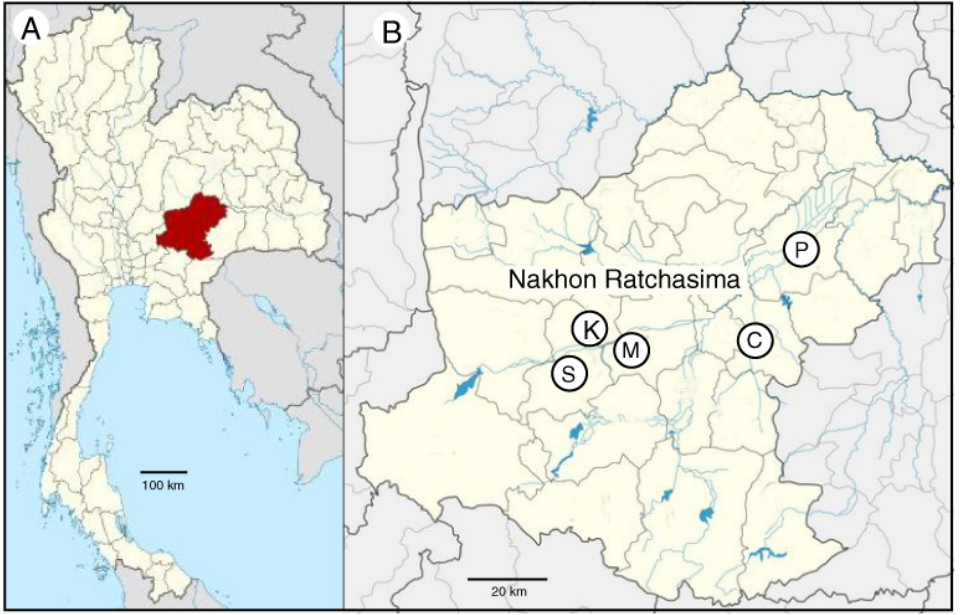
Figure 10. Maps showing Khorat Plateau fossil wood localities used in this study. ( A ) Thailand map showing Nakhon Ratchasima Province in red. ( B ) Specimens came from five districts within theprovince:C = Chakkarat, K—Kham Thale So, M = Mueang Nakhon Ratchasima, P = Phimai, S = Sung Noen.